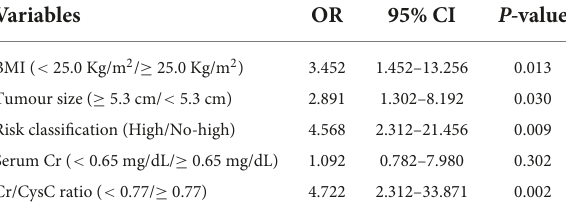
TABLE 2 Multivariate analyses of the clinicopathological characteristics for sarcopenia.